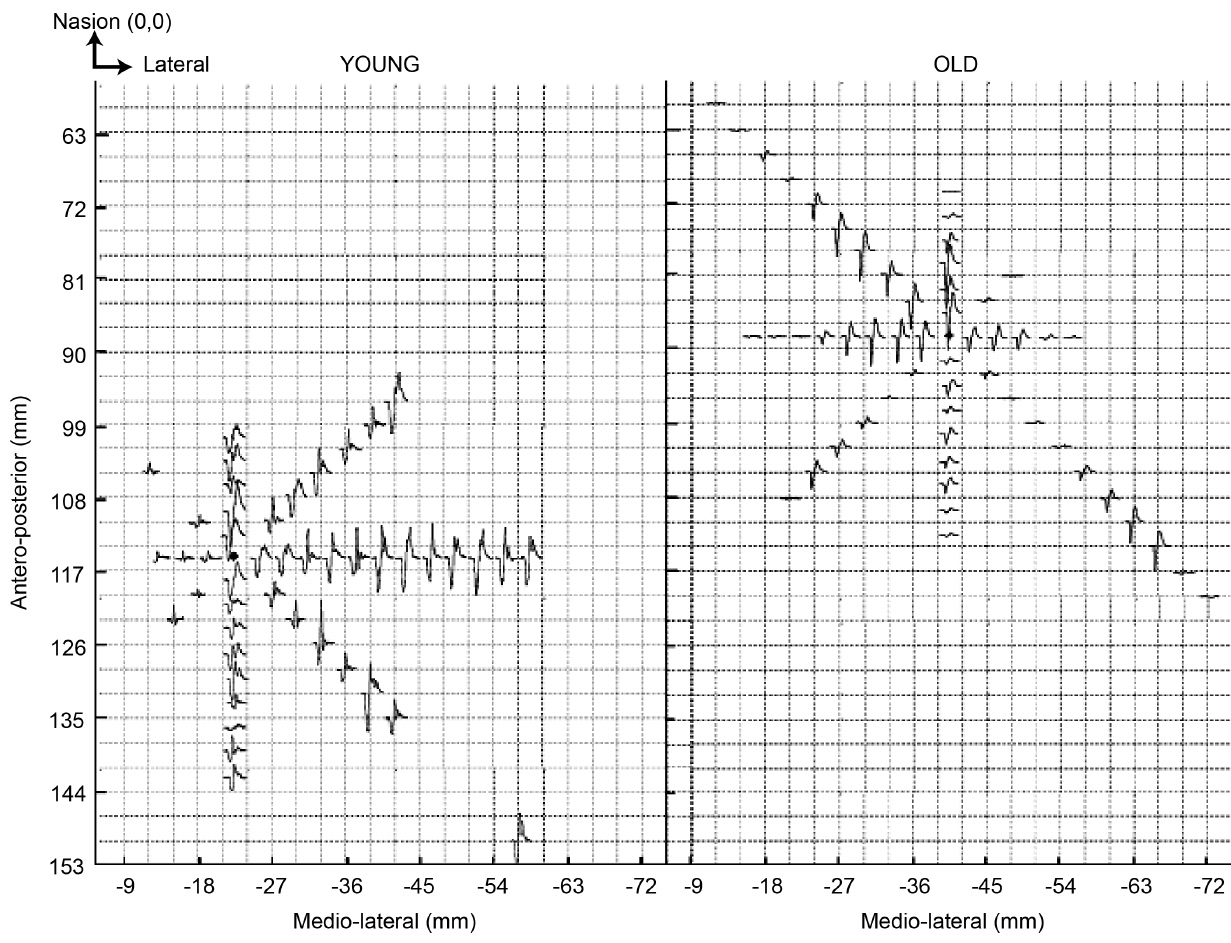
Figure 3. Representative motor maps in young and old individuals. Representative examples from a young and an older individual showing the size and spatial distribution of MEPs across the motor map of left biceps muscle in right hemisphere. The size (number of sites) did not vary significantly across groups (see also Fig. 4a). Note that map in the older individual is positioned anteriorly, which potentially explains why the center of gravity in older individuals was anterior too (Fig.